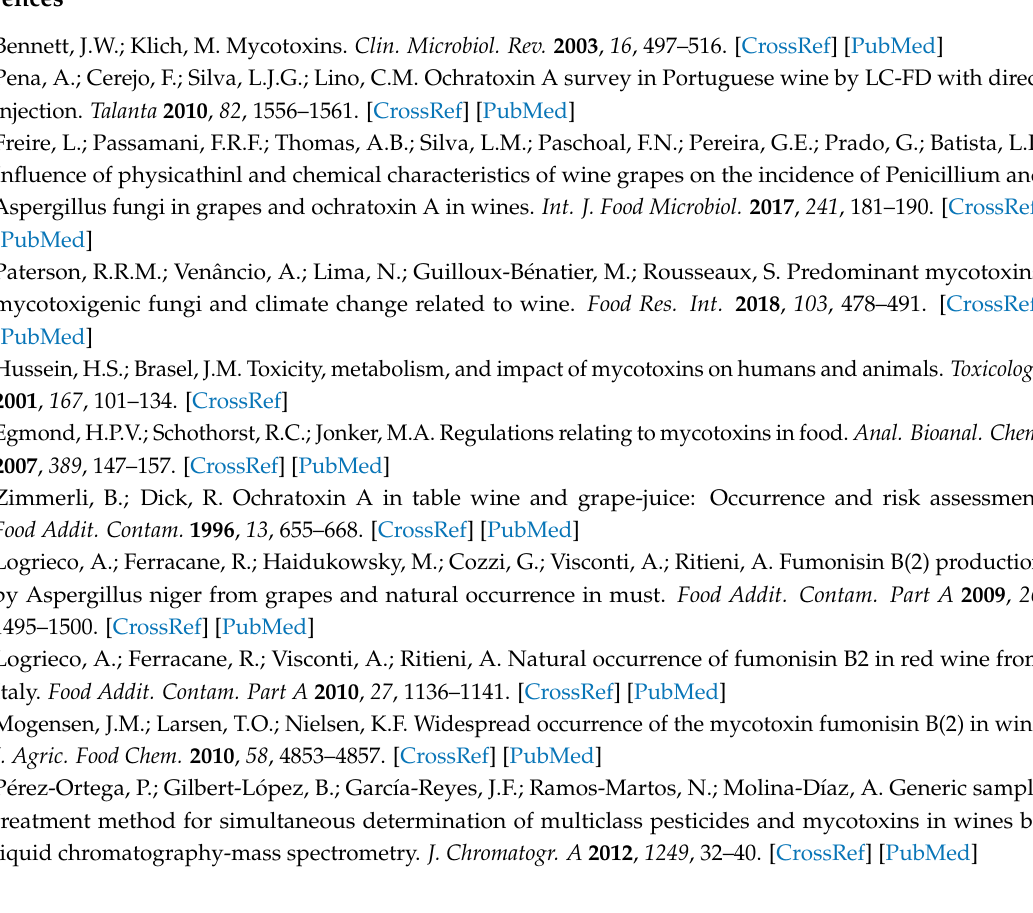
Table S1: The basic meteorological data of the Hexi Corridor region (according to statistics from 1981 to 2010), Table S2: Matrix effect and recovery percentage obtained by applying various dSPE clean-up sorbents and their mixtures, Table S3: Values of matrix effect observed at three concentration levels, Table S4: Recoveries and precisions for 20 mycotoxins which were spiked at three